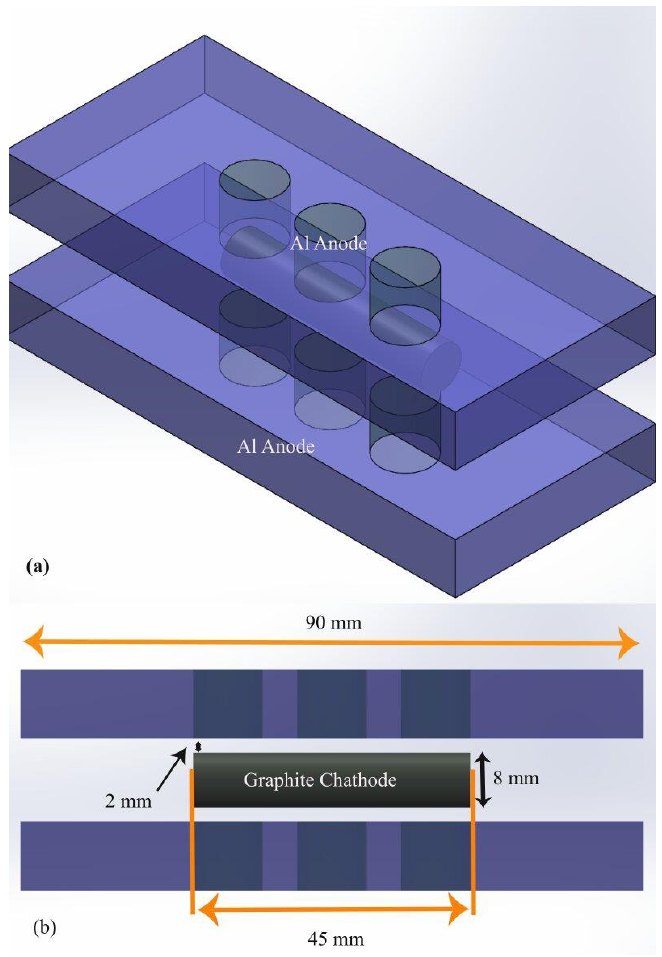
Figure 1. Schematic diagram of cylindrical ion source ( a ) 3-dimensional view ( b ) Geometrical.